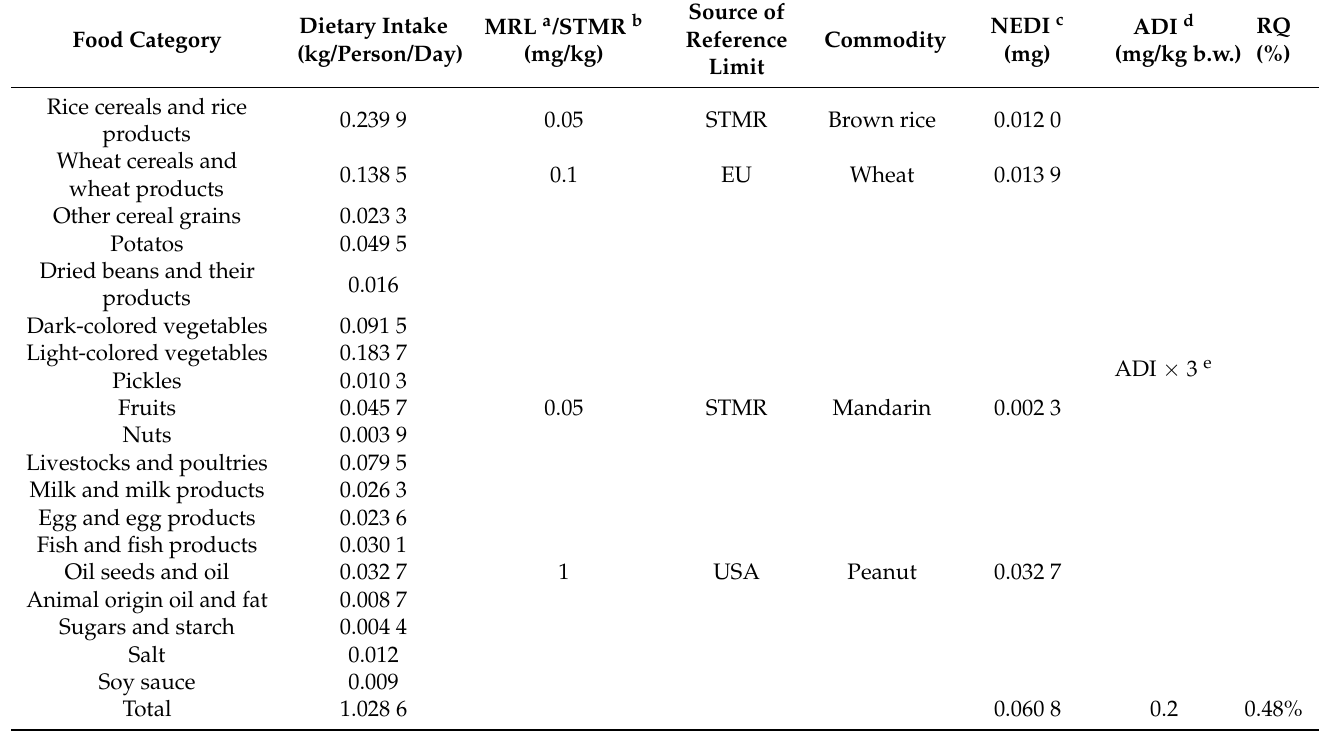
Table 3. The long-term dietary risk assessment of prohexadione-Ca based on Chinese food diet.